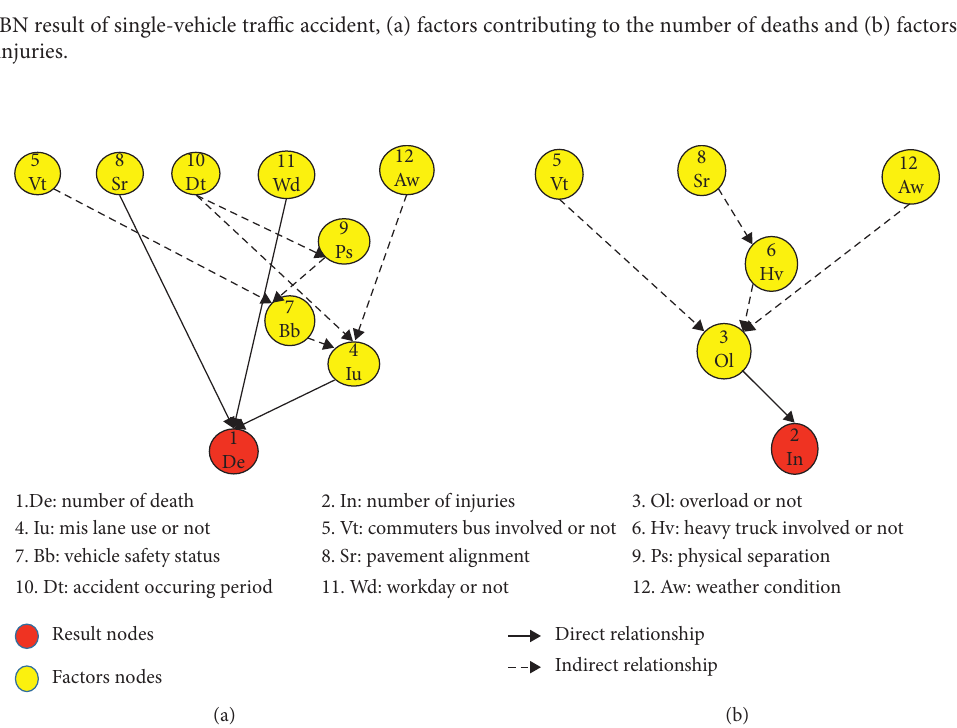
Figure 8: Final BN result of multivehicle traffic accident, (a) factors contributing to the number of deaths and (b) factors contributing to the number of